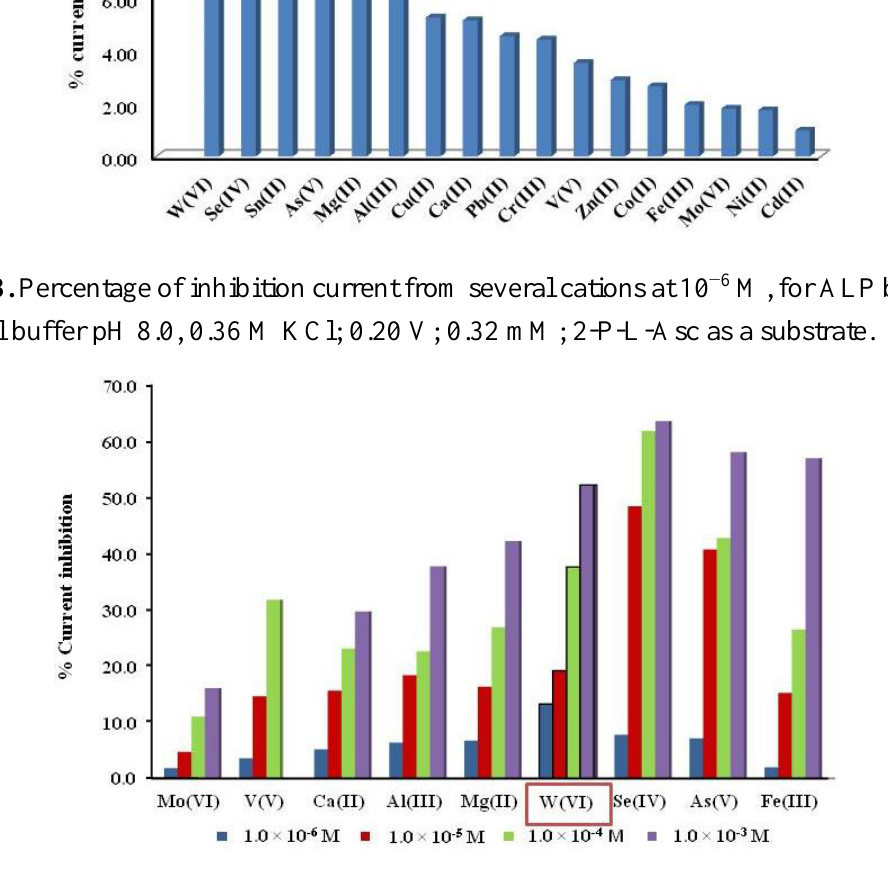
Figure 4. Percentage of inhibition current from several cations at different concentrations, for ALP biosensor, Tris HCl buffer pH 8.0, 0.36 M KCl, 0.20 V, 0.32 mM 2-P-L-Asc as a